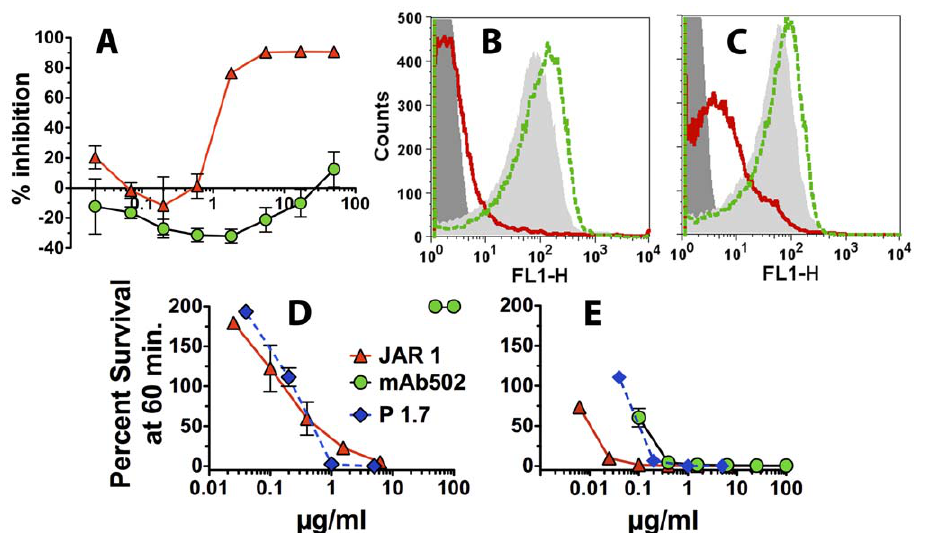
Figure 4. Inhibition of binding of fH in relation to anti-fHbp mAb bactericidal activity. Panel A. Inhibition of fH binding to recombinant fHbp as measured by ELISA. A fixed concentration of human fH (2 m g/ml) was incubated with different concentrations of anti-fHbp mAb JAR 1 (red triangles with solid red line) or mAb502 (green circles with dashed green line). Panels B. Inhibition of fH binding to live bacteria of wild-type group B strain H44/76 as measured by flow cytometry. A fixed concentration of fH ( , 90 m g/ml) was incubated with 2 m g/ml of JAR 1, or 2 or 50 m g/ml of mAb502. The source of human fH was 20% IgG-depleted human serum. Dark gray filled area, bacteria without fH as a negative control; Light gray filled area, fH without the addition of a mAb; fH and JAR 1 (red line); fH and mAb502, (green dashed line). Data for 2 or 50 m g/ml of mAb502 were similar; only 50 m g/ml histogram is shown. Panel C. Inhibition of fH binding to live bacteria of a mutant of group A strain Senegal 1/99 with over- expressed fHbp ID 5 as measured by flow cytometry. Symbols same as in Panel B. Panel D. Survival of N. meningitidis group B H44/76 strains after 60 min incubation with anti-fHbp mAbs and 20% human complement. JAR 1 (red triangles) and the anti-PorA P1.7 mAb control were bactericidal but not mAb502 (green circles). Panel E. Same as Panel D except infant rabbit complement was used instead of human complement. All three mAbs had activity. For each panel, the respective results were replicated in two independent experiments. Error bars represent ranges in values.